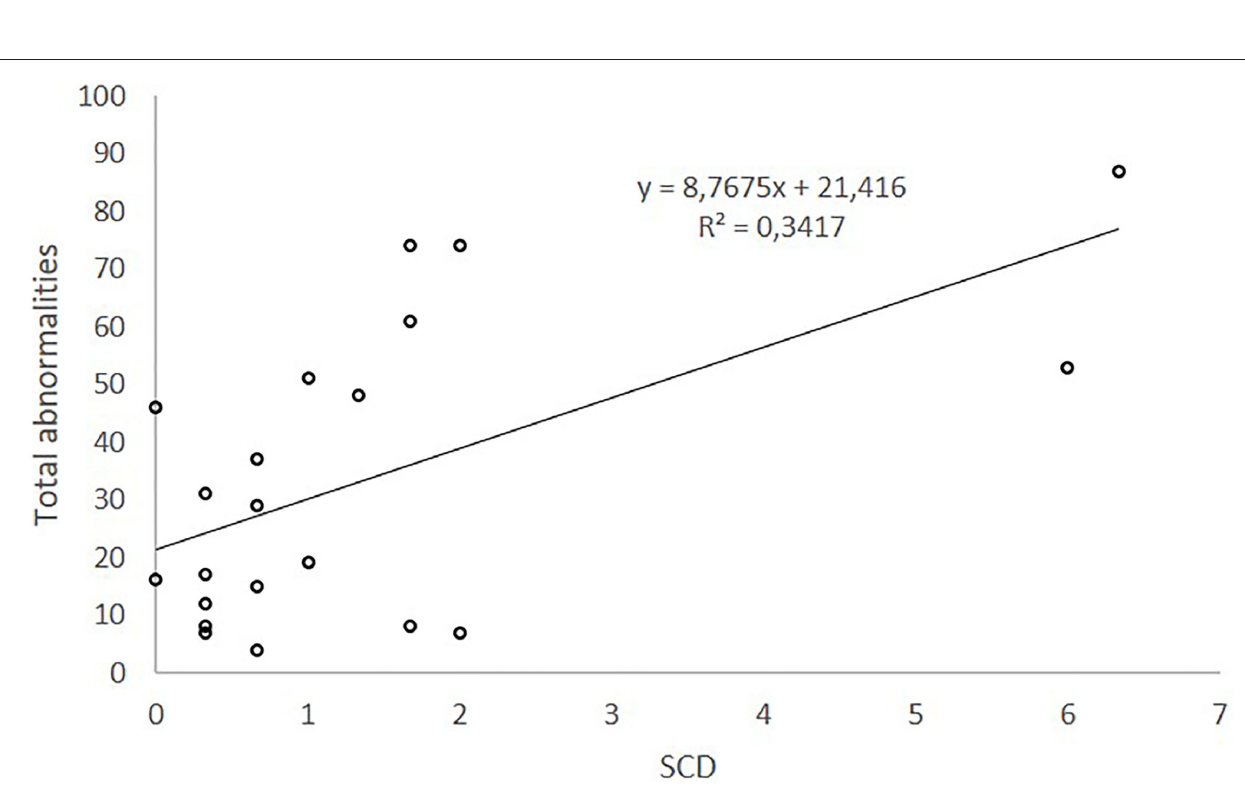
FIGURE 3 | Relationship between total abnormalities and sDF measured by